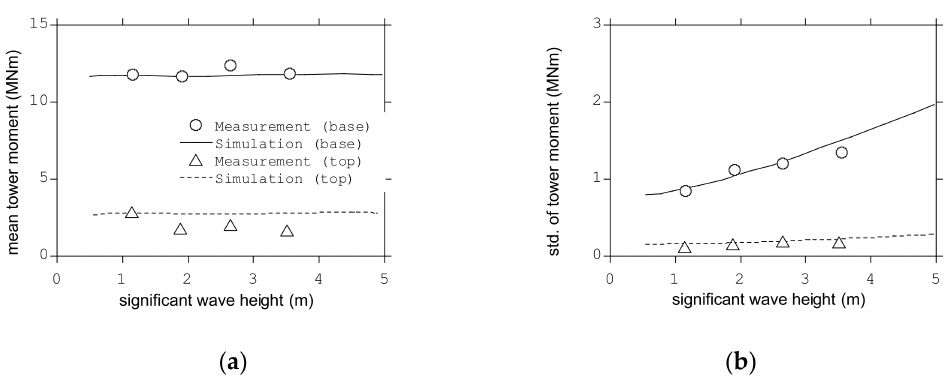
Figure 8. Effect of significant wave height on ( a ) mean and ( b ) standard deviation of fore-aft tower bending moments at the tower top and